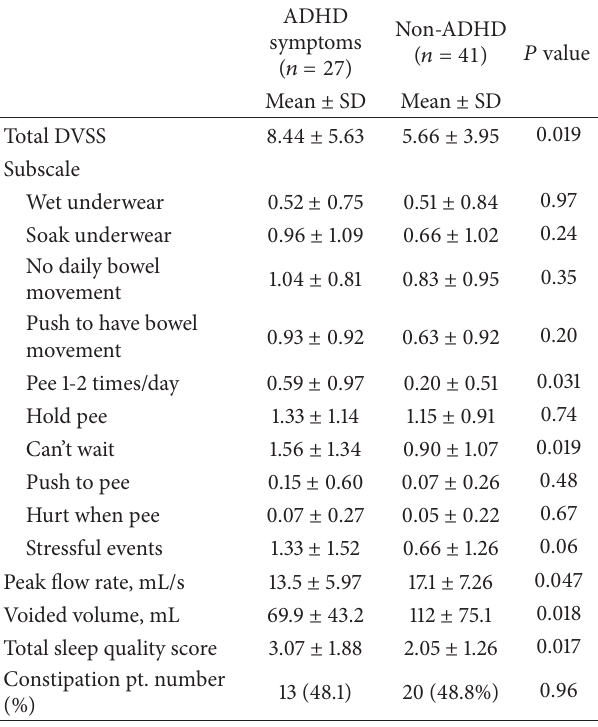
Table 1: Demographic characteristics categorized by the presence of ADHD symptoms in a total of 68 children with primary enuresis in urologic clinics.